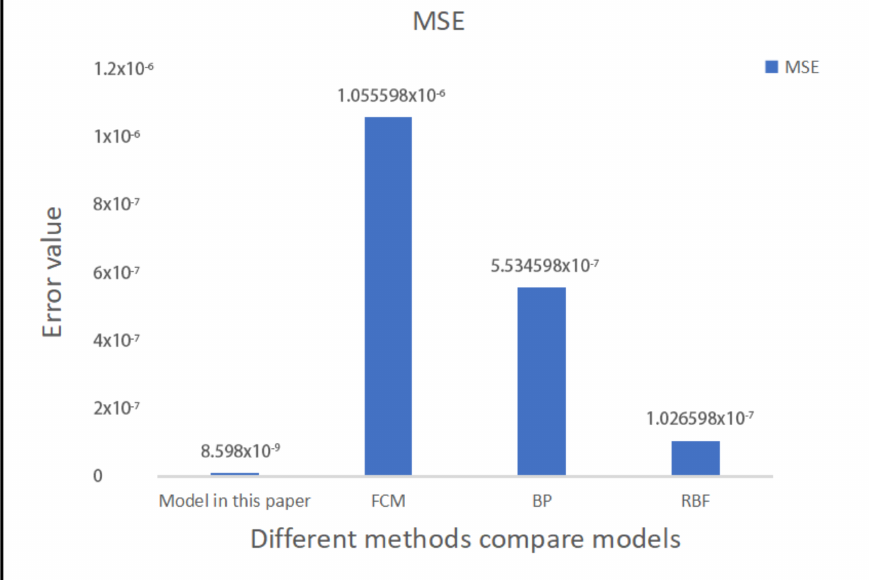
Figure 11. Comparison of mean square error of different